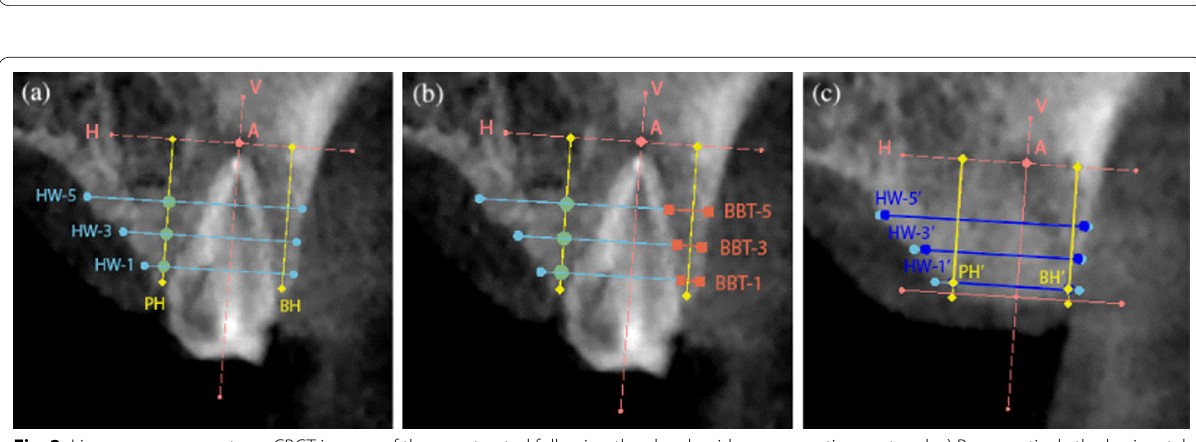
Fig. 2 Linear measurements on CBCT images of the case treated following the alveolar ridge preservation protocol. a ) Preoperatively the horizontal analysis was performed at 1, 3 and 5 mm (HW-1, HW-3, HW-5) and the vertical analysis was performed on the buccal and palatal side (BH, PH); b ) preoperatively the buccal bone thickness was measured at 1, 3 and 5 mm (BBT-1, BBT-3, BBT-5); c ) postoperatively the horizontal analysis was performed at 1, 3 and 5 mm (HW-1, HW-3, HW-5) and the vertical analysis was performed on the buccal and palatal side (BH,